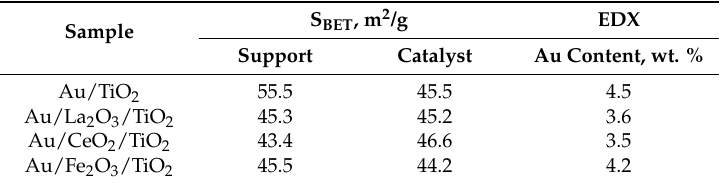
Table 2. Textural properties of supports and catalysts, and gold content in the studied catalysts.